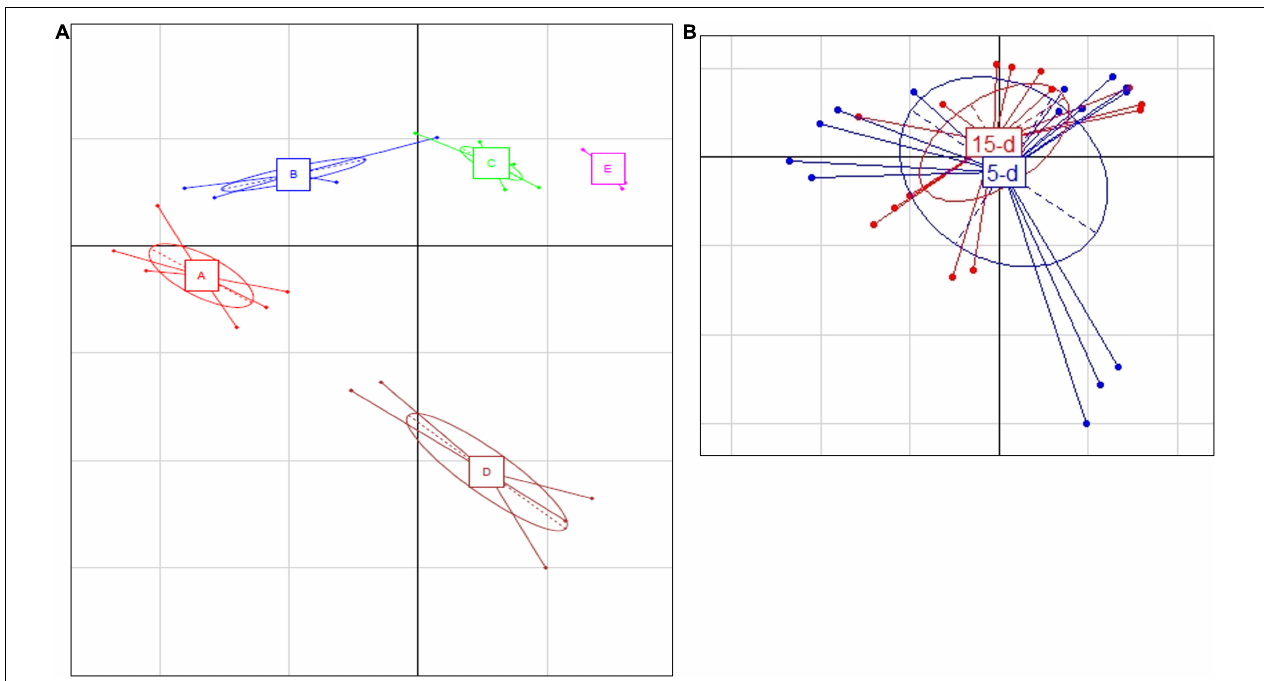
FIGURE 1 | (A) Principal Component Analysis based on ASV relative abundance of bacterial microbiota targeted by 16S rRNA. (A) Differences between the different dairy plants; the first component (horizontal) accounts for the 59.91% of the variance, and the second component (vertical) accounts for the 10.84%. The five different plants are indicated as follows: A (red bars), B (blue bars), C (green bars), D (brown bars), and E (magenta bars). (B) Differences between 5-day (blue) and 15-day ripened cheese (red) analyzed; the first component (horizontal) accounts for the 28.16% of the variance, and the second component (vertical) accounts for the 21.85%. Ellipses in the graph are drown around similar cluster. The bars which originated from a common centroid highlighted the difference between samples belonging to the same cluster.